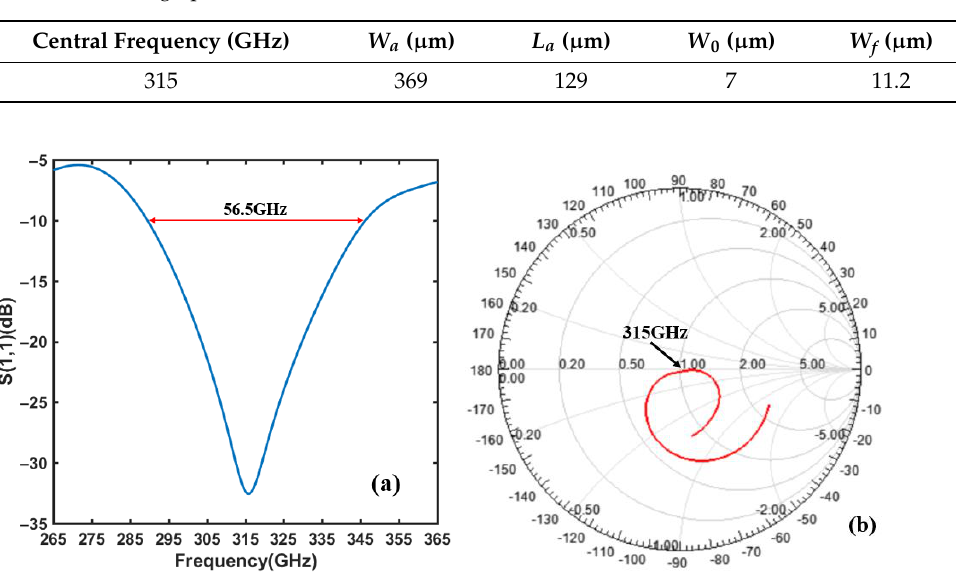
Figure 4. ( a ) Simulation result of the S(1,1) parameter for the microstrip patch antenna. ( b ) Smith chart for the impedance matching characteristics between the microstrip patch antenna and the gate electrode.